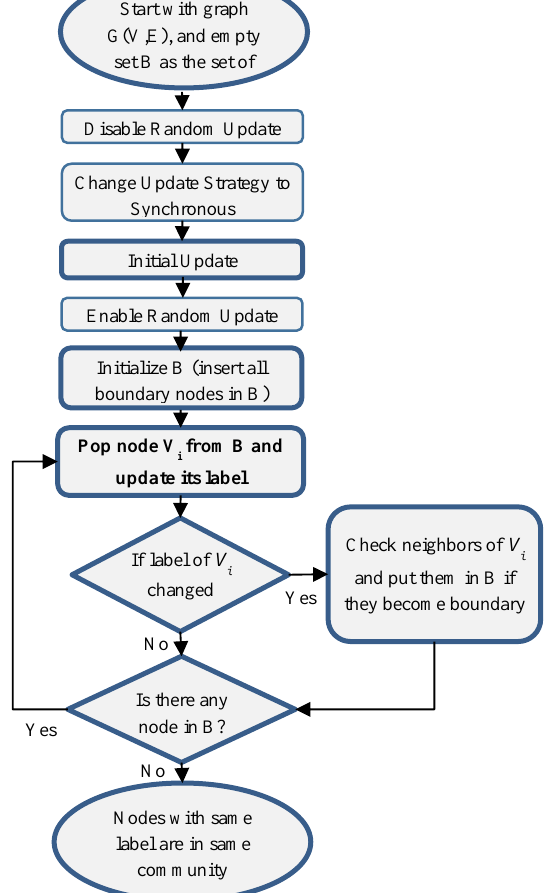
Figure 2. Flowchart of phase 1 in the proposed SD-GCN method